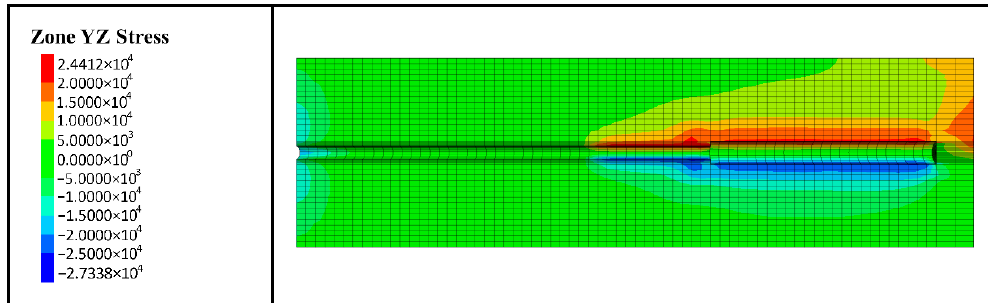
Figure 7. Shear stress variation of anchor cable during plastic penetration.